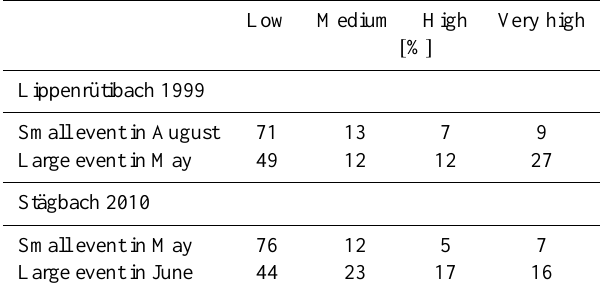
Table 1. Spatial extent of hydrological risk classes for a large and a small runoff event in the Lippenrütibach and the Stägbach catch- ment relative to the total agricultural area in